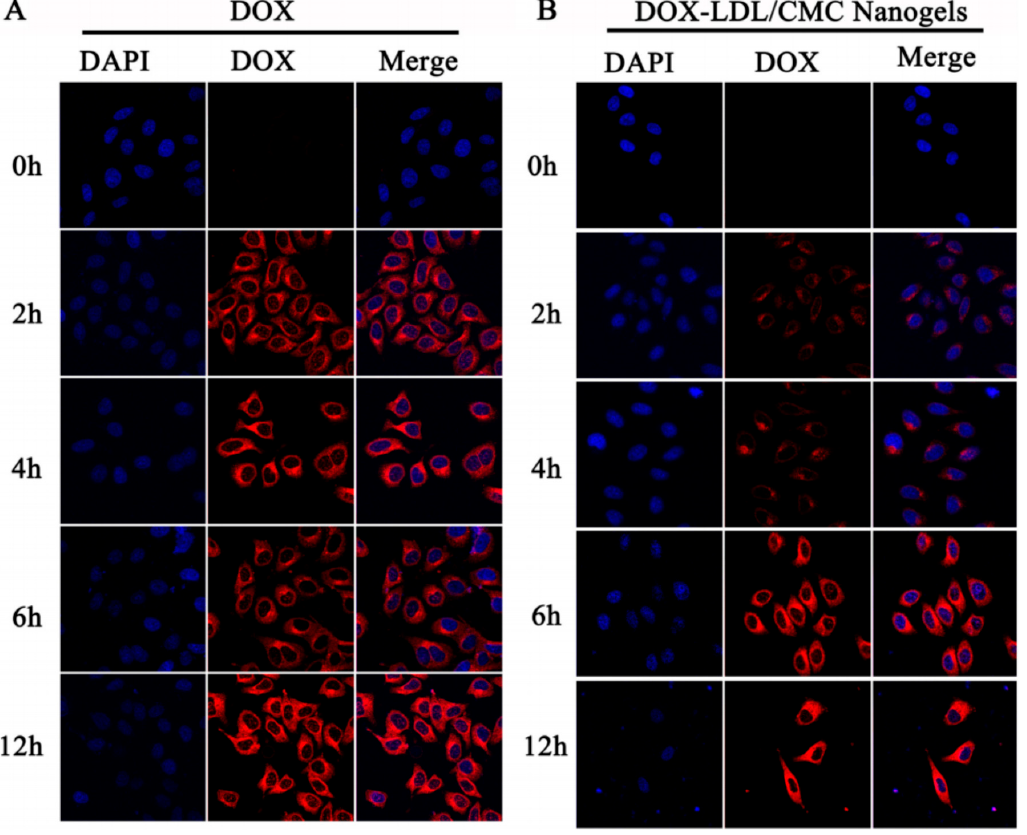
Figure 15. Confocal laser scanning microscopy (CLSM) images showing intracellular uptake of doxorubicin (DOX) ( A ) and DOX-loaded low-density lipoprotein (LDL)/carboxymethylcellulose (CMC) nanogels ( B ) by human hepatocellular liver carcinoma cell lines (HepG2 cells). DOX dosage was 4.0 g/mL. It was investigated qualitatively by CLSM. [140]. 4.0 g / mL. It was investigated qualitatively by CLSM